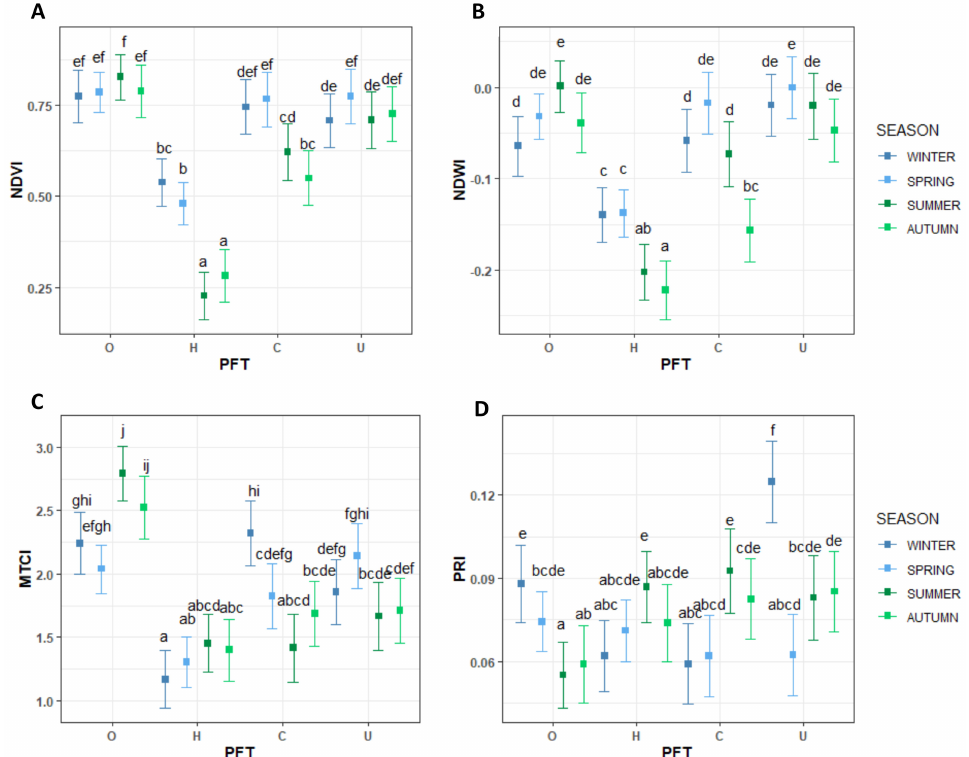
Figure 4. ANOVA for each vegetation indices: ( A ) NDVI; ( B ) NDWI; ( C ) MTCI; and ( D ) PRI. Average values of VIs (NDVI, NDWI, MTCI, PRI) per PFT (O—cork oak; H—herbaceous vegetation; C—cistus; U—ulex) and season (winter, spring, summer, autumn). Different letters indicate significant statistical differences ( p -value ≤